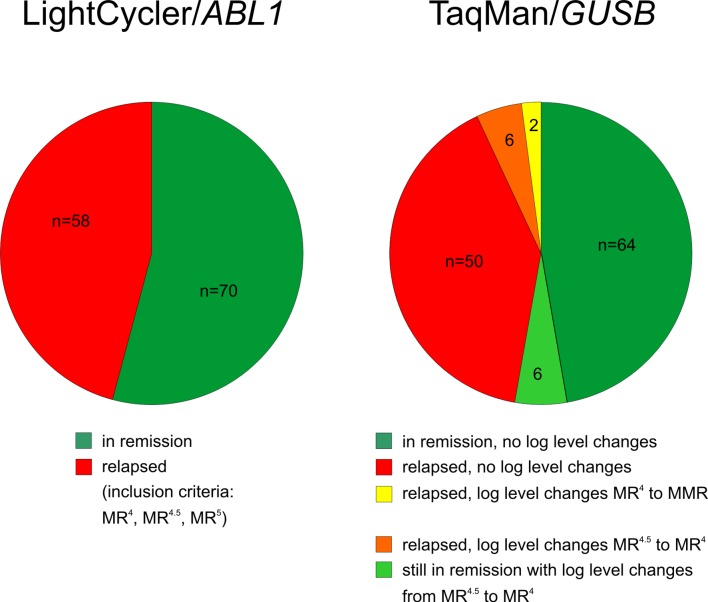
EURO-SKI samples comparatively tested with LC/ABL1 and TM/GUSB system.Comparison of EURO-SKI stopping trial interim TFR analysis data (left pie) with a “what if” scenario (right pie) where patient inclusion was based on more sensitive TM/GUSB instead of LC/ABL1 assays. Of 128 patients who were evaluated by LC/ABL1 (left pie), 58 (45%) relapsed within 24 months of TKI discontinuation. According to data based on TM/GUSB monitoring of 128 EURO-SKI patients (right pie), two of the relapsing patients (2/58 = 3.4%) were re-classified from MR4 to MMR and, therefore, both specimen analyzed did not meet the inclusion criteria anymore (yellow sector). The same holds true for another 6 patients (6/58 = 10%) when MR4 was excluded as inclusion criterion (orange sector). Six samples of patients in remission were re-classified from MR4.5 to MR4 but are currently still in TFR (light green sector).